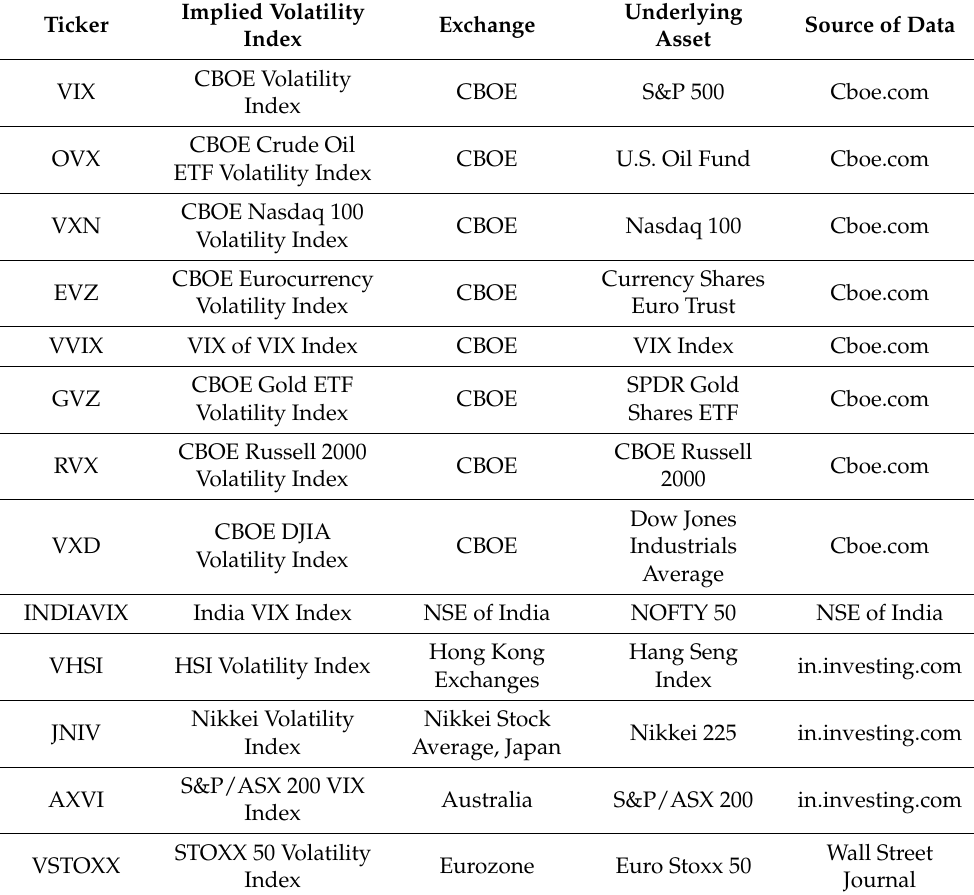
Table 2. List of implied volatility